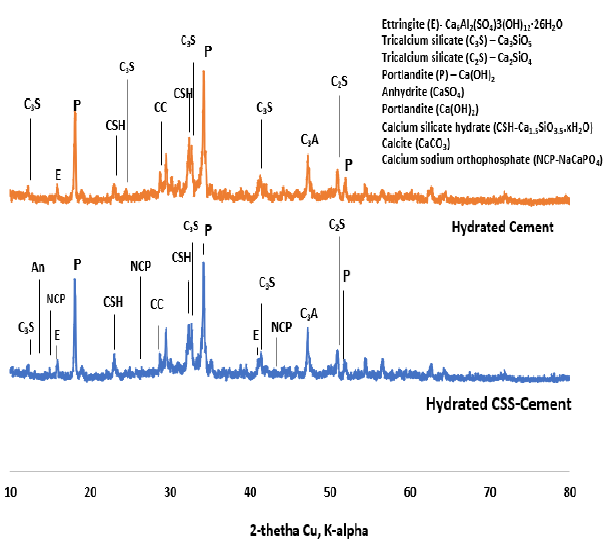
Figure 8. X-ray diffractogram of coffee-silverskin-blended ( top ) and cement paste ( bottom